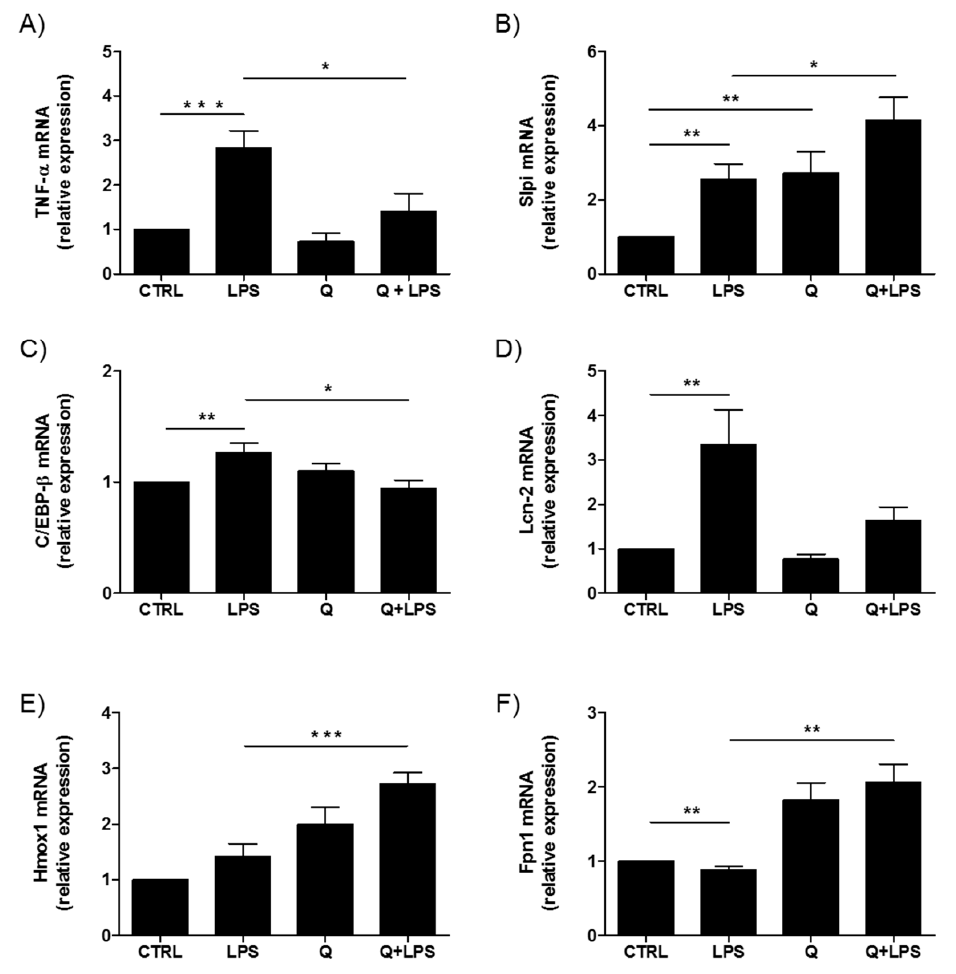
Figure 6. The e ff ect of quercetin on WT intestinal organoids. Expression of TNF- α ( A ), Slpi ( B ), C / EBP- β ( C ), LCN-2 ( D ), Hmox ( E ), and Fpn1 ( F ) was detected by real-time PCR. Relative expression of selected genes was calculated relative to untreated WT-organoids (control). Histograms represent mean expression ± SEM of four independent experiments. Unpaired two-tailed Student’s t-test was used for statistical analysis. *** p < 0.001, ** p < 0.01, * p < 0.05.